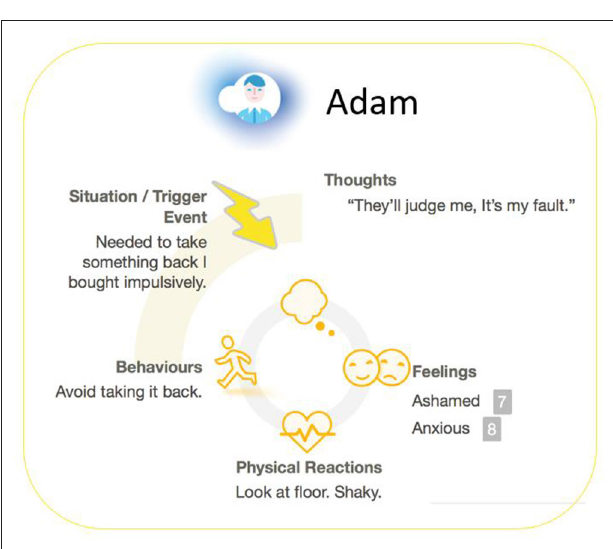
FIGURE 2 | A screenshot from space from money worries: a case illustration of thought-feelings-behavior cycle around financial difficulties.